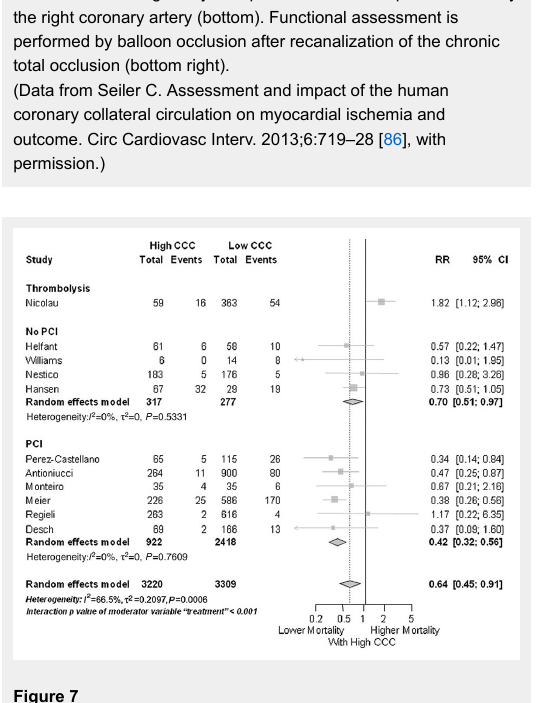
Forest plot of risk ratios for mortality risk, stratified by type of intervention (PCI, no PCI, and thrombolysis). CAD, coronary artery disease; CCC, coronary collateral circulation; CI, confidence interval; MI, myocardial infarction. Horizontal bars indicate 95% confidence intervals. (Data from Meier P, et al. Beneficial effect of recruitable collaterals: a 10-year follow-up study in patients with stable coronary artery disease undergoing quantitative collateral measurements.